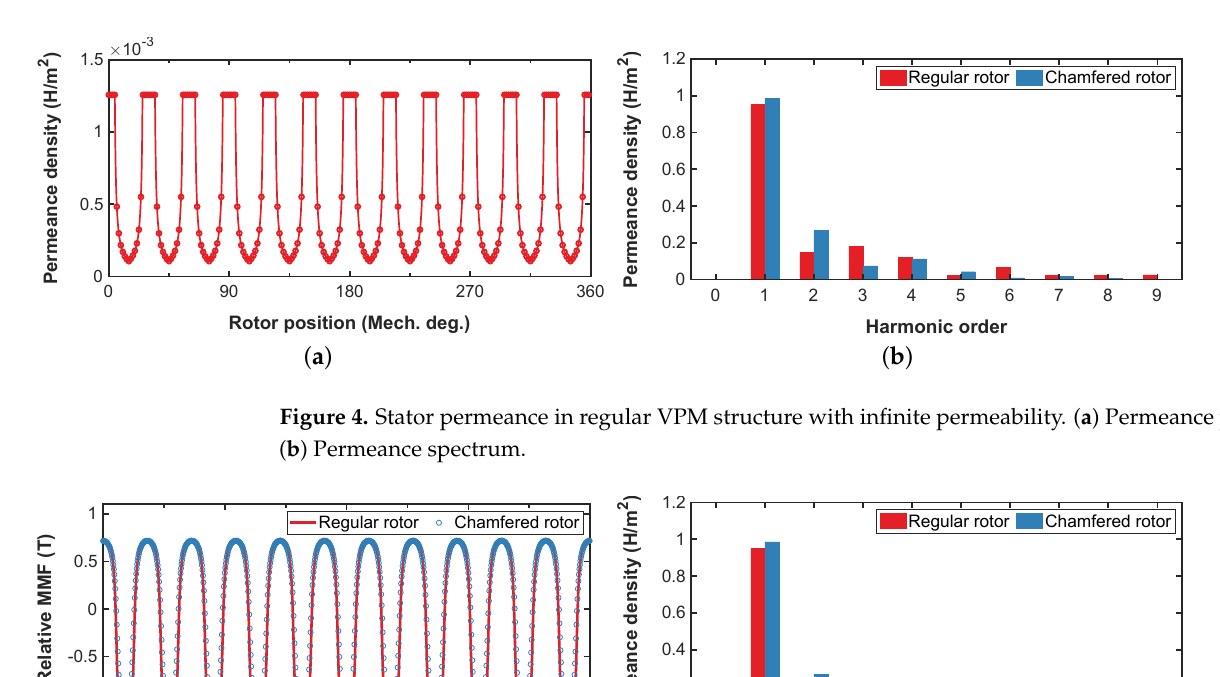
Rotor position (Mech. deg.)